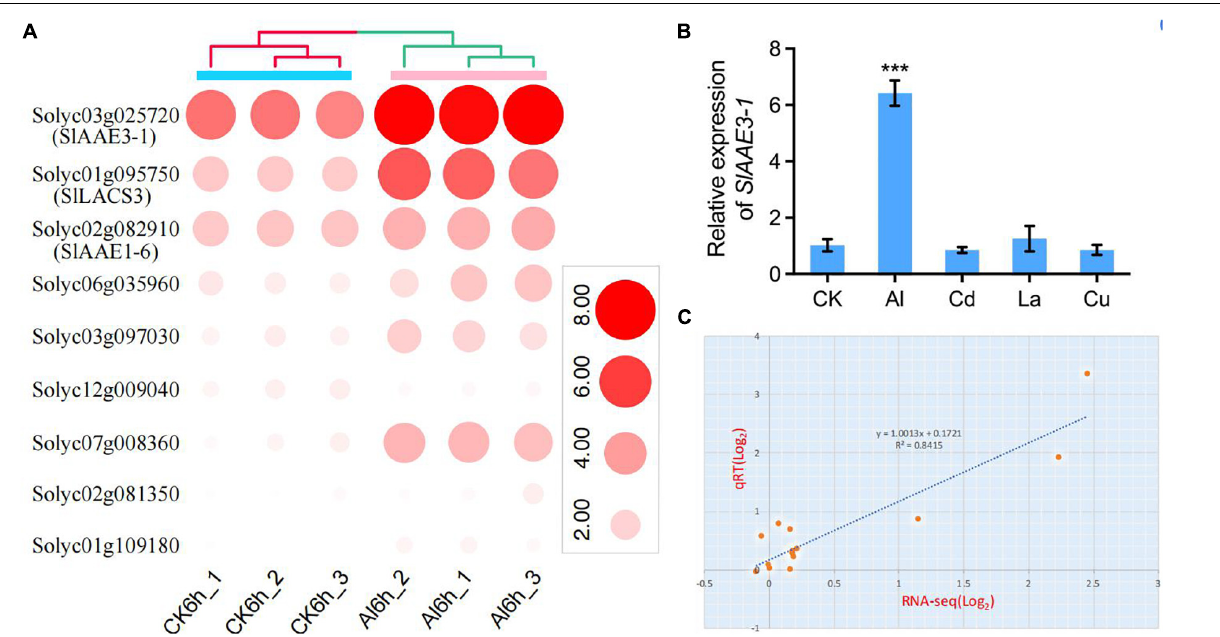
FIGURE 7 | Expression profiles of SlAAEs under Al stress. (A) Heatmap of nine differentially expressed SlAAE genes during Al stress. (B) Expression specificity of SlAAE3-1 gene. Seedlings were subjected to 1/5 Hoagland solution containing 5 µ M AlCl 3 , or 5 µ M CdCl 2 , 5 µ M LaCl 3 , or 3 µ M CuCl 2 for 6 h. Data are the means ± SD ( n = 3); the asterisk indicates significant differences between control and treatment at P < 0.001 using one-way ANOVA. (C) Correlation of gene expression levels between the RNA-seq data and quantitative reverse-transcriptase (qRT-PCR) analysis. Fourteen SlAAEs potentially responding to Al were selected and subjected to the qRT-PCR analysis using the same RNA as for RNA-seq. Both x - and y -axes are shown in Log 2 scale.